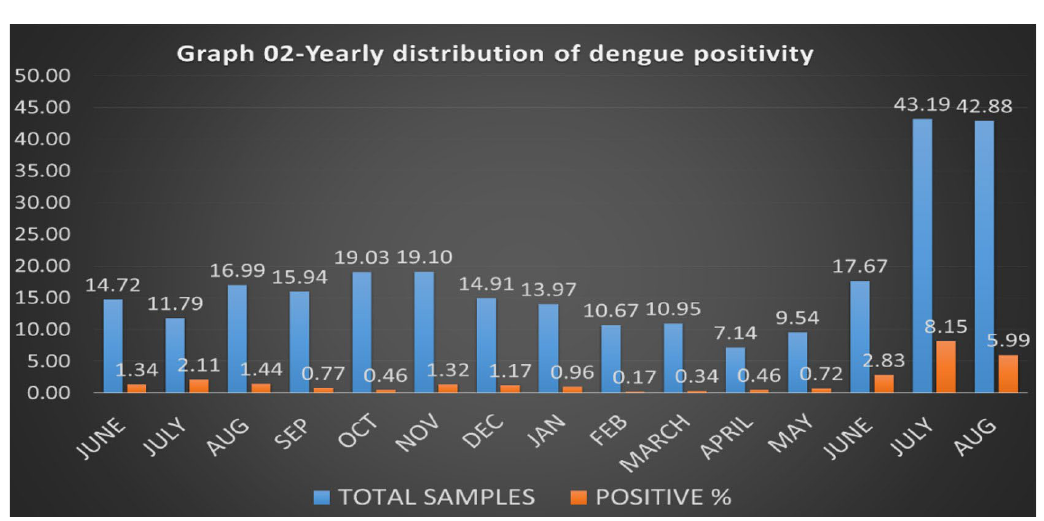
Graph 1. Distribution of dengue seropositivity